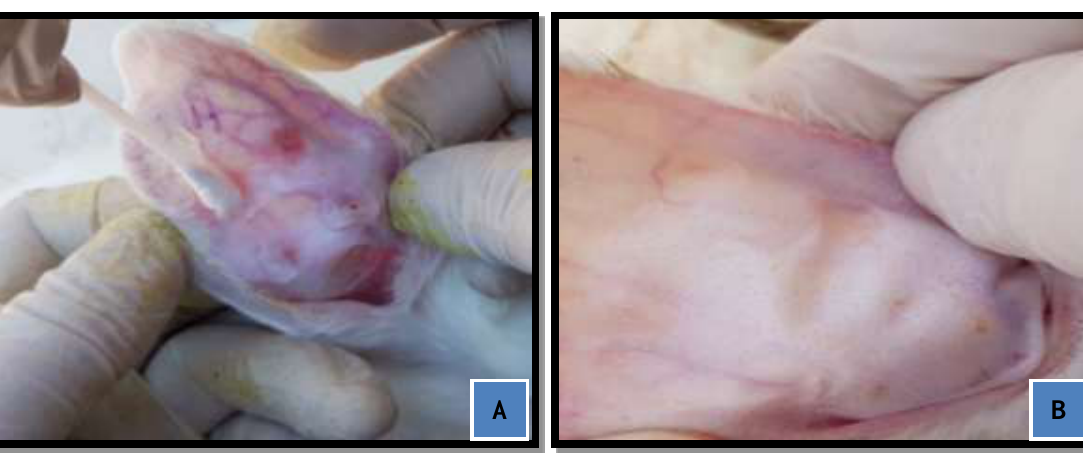
Figure 2.Treatment with triamcinolone acetonide